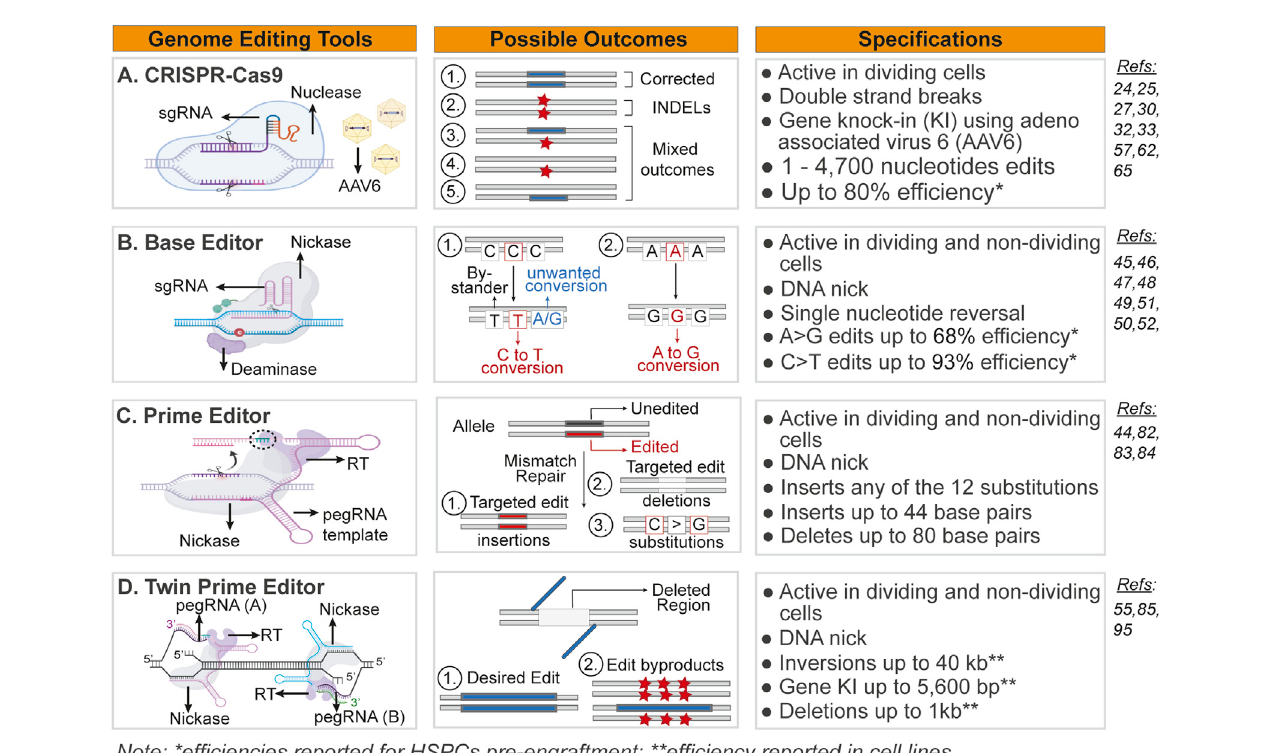
FIGURE 1 Overview of genome editing platforms discussed in this review. Schematics and description of the genome editing tools, genomic outcomes following editing and speci fi cations for (A) CRISPR/Cas9-AAV6, (B) Base Editing (BE), (C) Prime Editing (PE), and (D) Twin Prime Editing platforms. sgRNA, single guide RNA; Nuclease, Cas9; Nickase, an engineered Cas9 nuclease with a single-stranded “ nick ” DNA cutting activity; AAV6, adeno-associated virus of serotype 6; INDELs, insertion and deletions; pegRNA, prime editing guide RNA; RT, reverse transcriptase; HSPCs, hematopoietic stem and progenitor